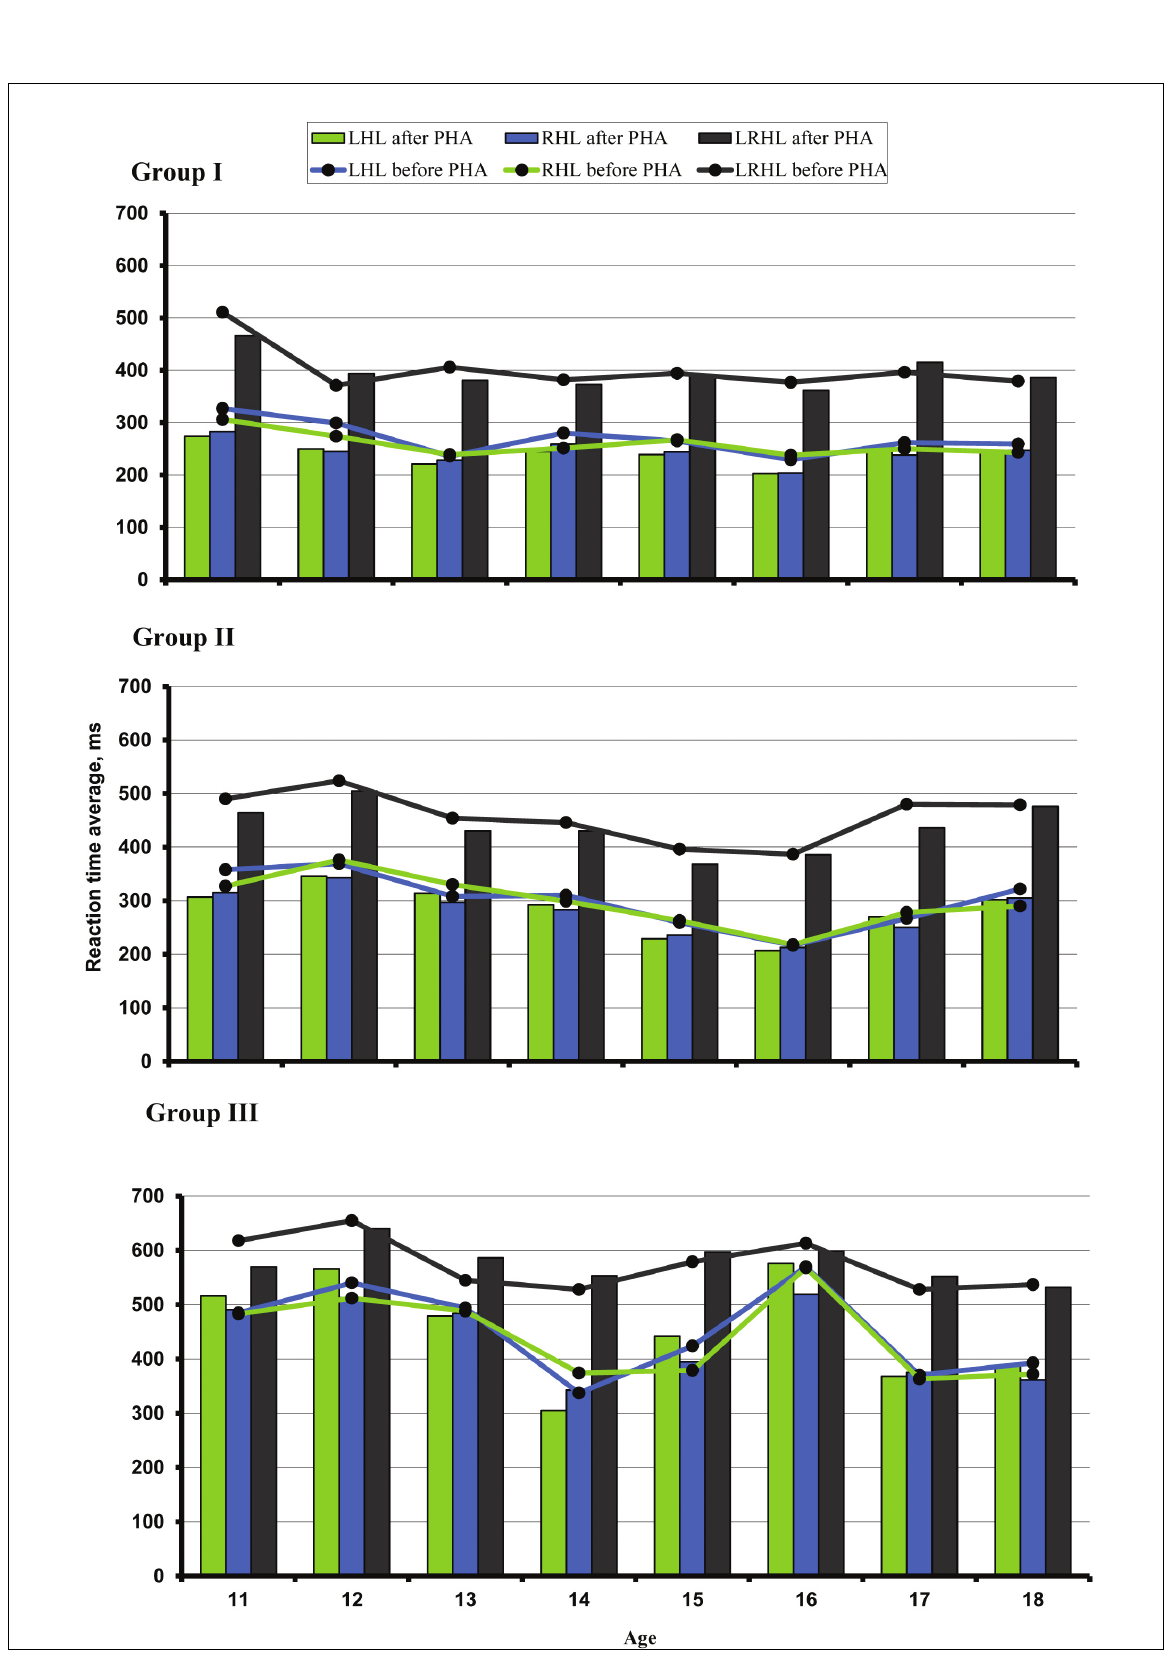
Figure 2. Average reaction time of 11–18 years old